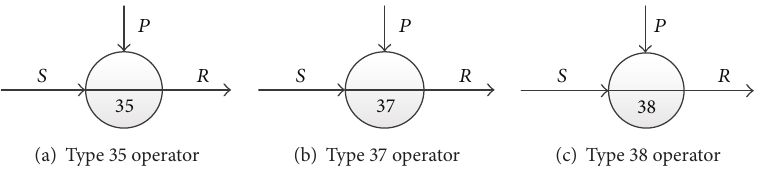
Figure 1: GO-FLOW operators commonly used.